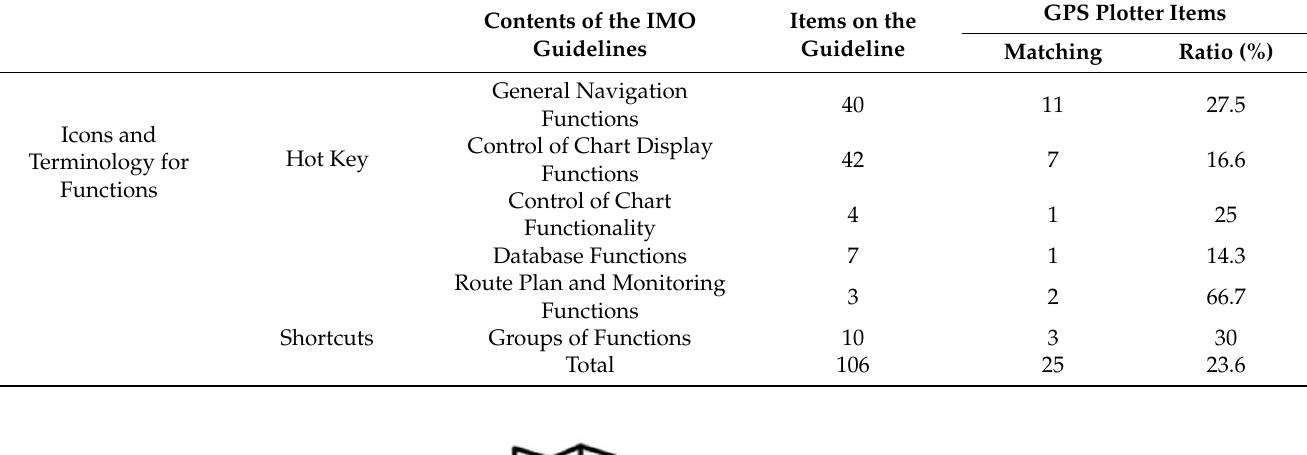
Table 1. Items of the user survey on the global positioning system (GPS) plotter.